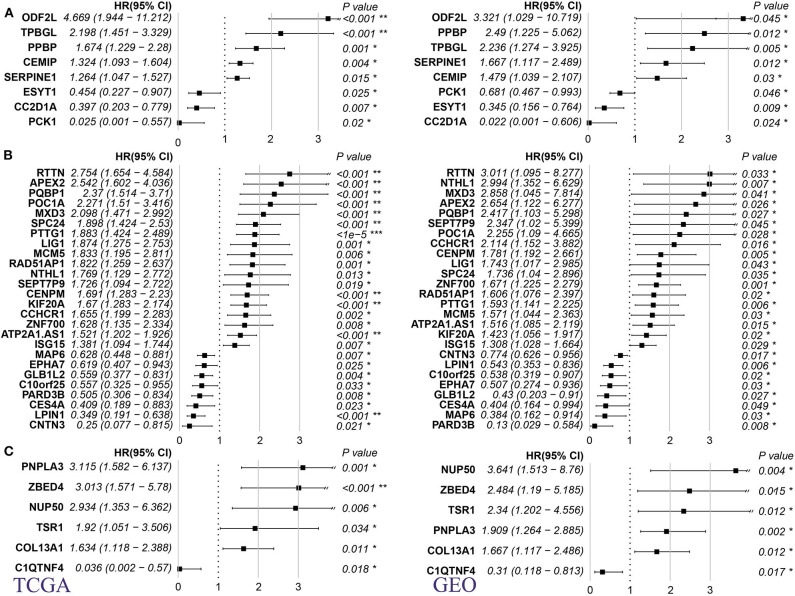
Relationship between MRS of 3 pathological subtypes of sarcoma and prognosis of metastasis. (A) DL. (B) LMS. (C) UPS (Left panel: TCGA dataset; right panel: GSE41258 dataset. HR: hazard ratio, p-value is log rank test p). *p < 0.05, **p < 0.001, and ***p < 0.0001.